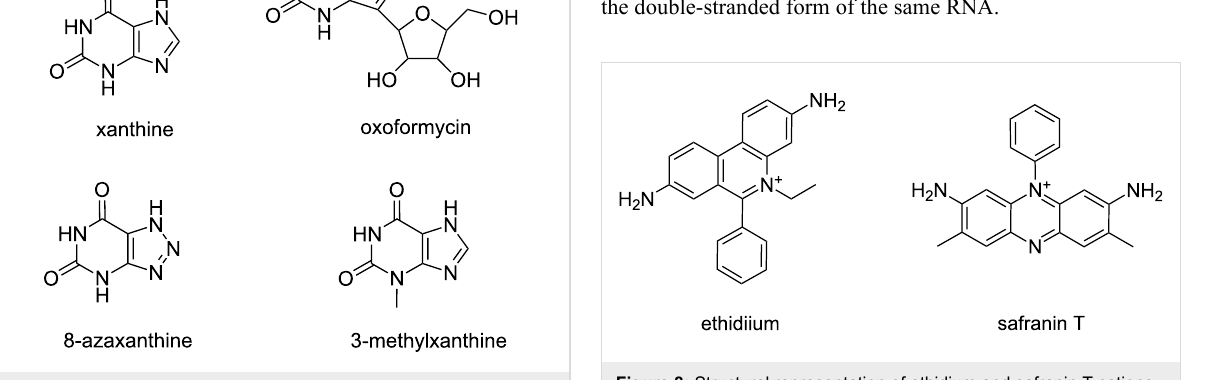
Figure 6: Schematic representation of the purine derivatives able to bind poly(rA), studied by Davies [17].